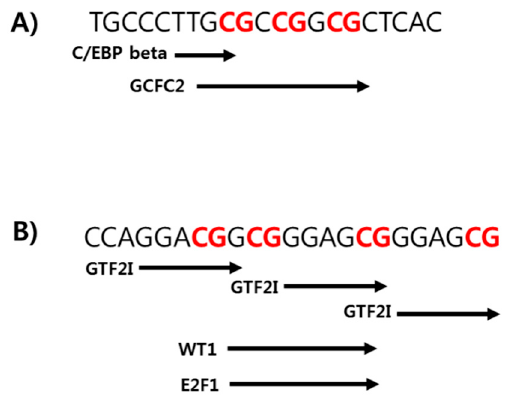
Figure 4. Prediction binding site analysis of TSPOAP1-AS1 promoter region. PROMO / transcription factor binding sites (TFBS) analysis on the sequences of CpG sites 11–13 ( A ) and 18–20 ( B ) of the TSPOAP1-AS1 promoter region. Each black arrow indicates the specific transcription factor identified its predicted binding sequence.